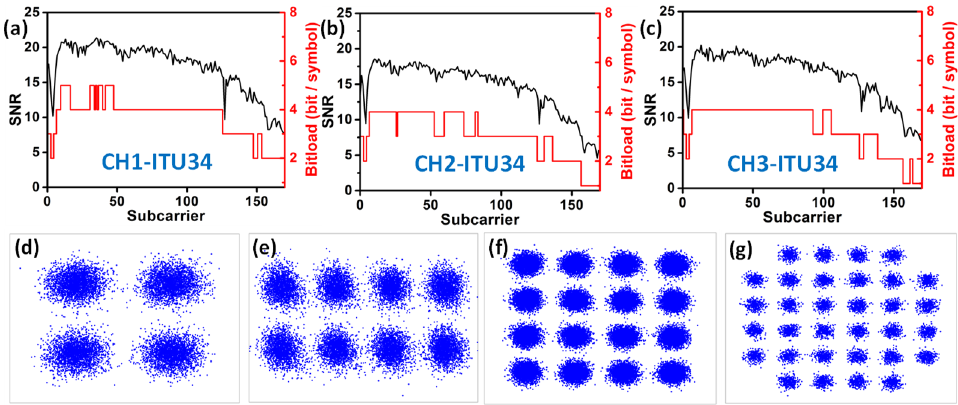
Figure 9. Experimental SNR and bit-loadings for each subcarrier in ( a ) CH1, ( b ) CH2 and ( c ) CH3 at the 1550.12 nm (ITU-34) wavelength channel. Typical constellations of ( d ) 4-QAM, ( e ) 8-QAM, ( f ) 16-QAM, ( g ) 32-QAM.